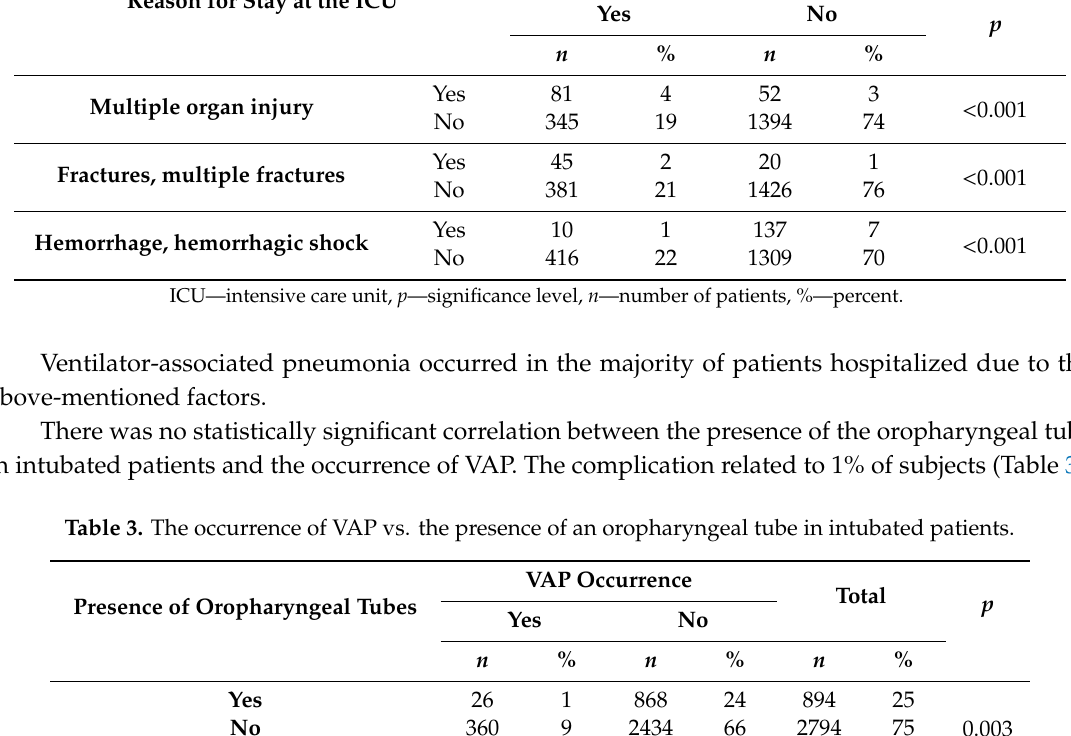
Table 2. The occurrence of VAP vs. the cause of entering the ICU. Reason for Stay at the ICU Multiple organ injury Fractures, multiple fractures